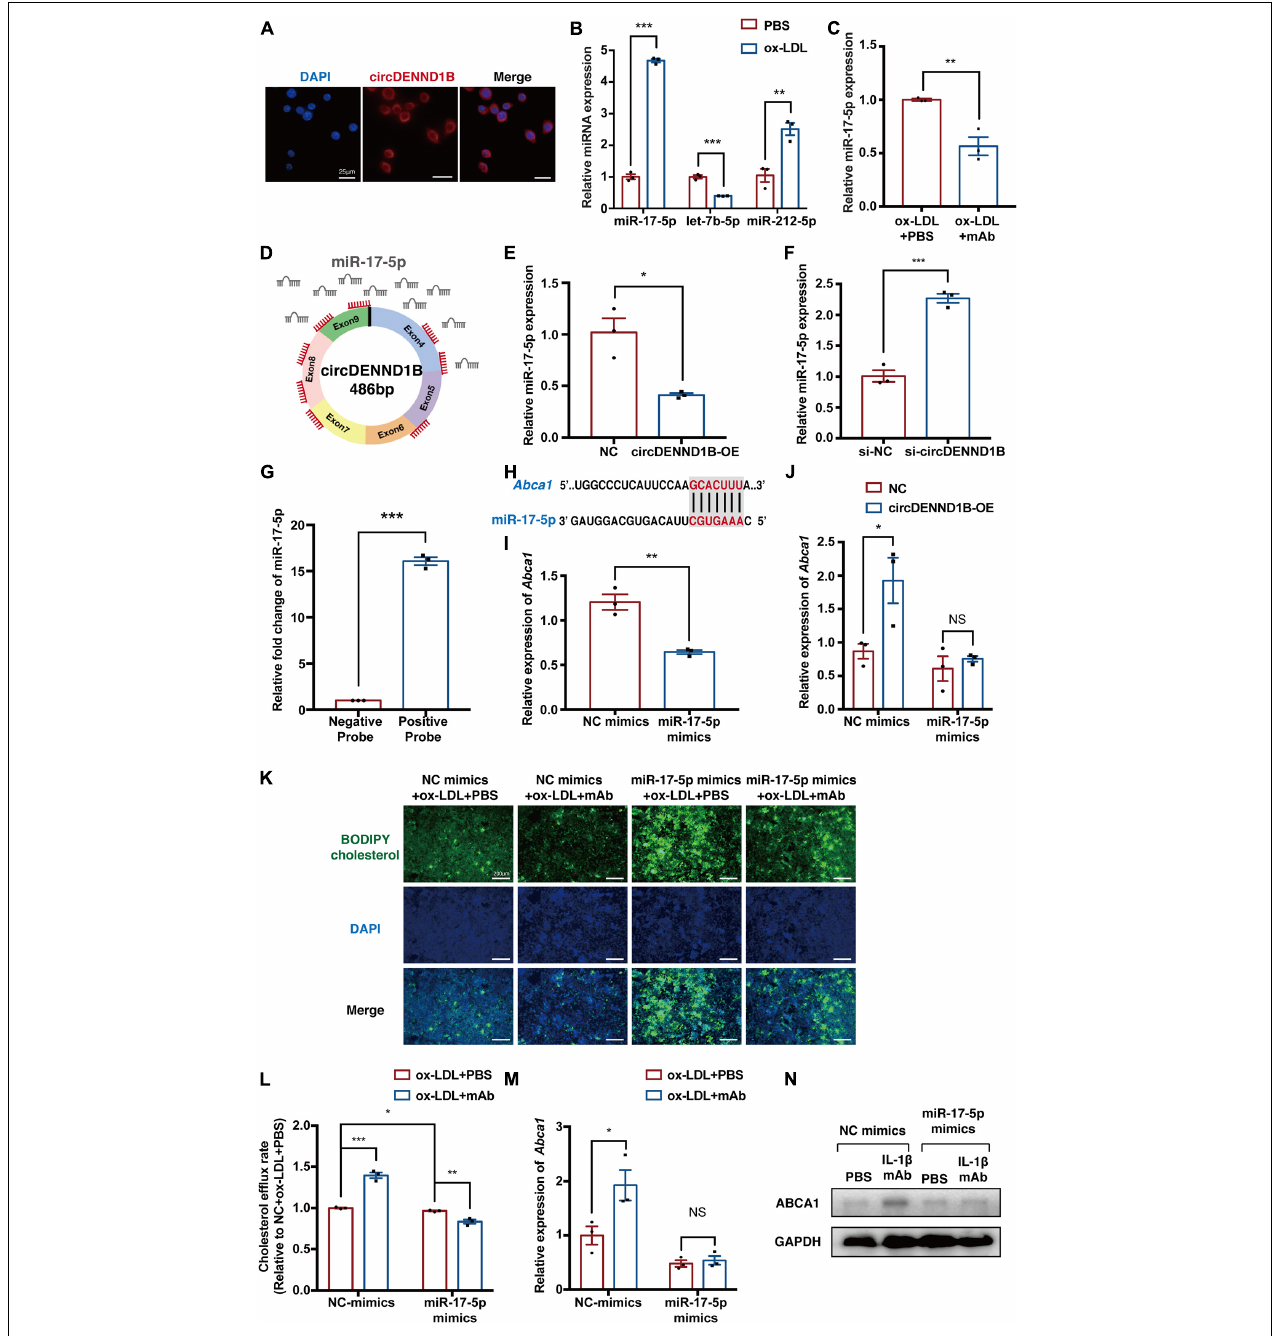
FIGURE 5 | circDENND1B/miR-17-5p/ Abca1 inhibits foam cell formation induced by IL-1 β mAb. (A) Fluorescence in situ hybridization (FISH) assay showing that circDENND1B is localized in the cytoplasm. (B) qRT-PCR results of let-7b-5p, miR-17-5p and miR-212-5p in ox-LDL-treated cells. (C) qRT-PCR results of miR-17-5p in cells treated with ox-LDL and PBS or IL-1 β mAb. (D) Schematic of the miR-17-5p sponge mechanism of circDENND1B, showing eight binding sites (red) of miR-17-5p (gray) in circDENND1B. (E) qRT-PCR shows miR-17-5p expression decreased after overexpressing circDENND1B. (F) qRT-PCR shows miR-17-5p expression increased after knocking down circDENND1B. (G) RNA pull-down assay confirmed the binding between circDENND1B and miR-17-5p. (H) miR-17-5p was predicted to bind the 3 (cid:48) UTR of Abca1 . (I) qRT-PCR results of Abca1 in foam cells treated with NC mimics or miR-17-5p mimics. (J) qRT-PCR results of Abca1 in cells transfected with miRNA mimics and overexpressing circDENND1B. (K) Representative images of the BODIPY assay showing the impact of miR-17-5p mimics and IL-1 β mAb on cholesterol efflux. (L) Cholesterol efflux rate in miR-17-5p-mimics-treated cells, measured by BODIPY assay. (M) qRT-PCR results of Abca1 in cells transfected with miRNA mimics ( n = 3 per group). (N) WB results of ABCA1 in cells transfected with miR-17-5p and treated with ox-LDL plus PBS or IL-1 β mAb. The qRT-PCR data of mRNA were normalized to GAPDH data ( n = 3 per group), and miRNA expression levels were normalized to U6 levels ( n = 3 per group). NC, negative control; OE, overexpression; NC mimics, negative control miRNA mimics. * p < 0.05, ** p < 0.01, *** p < 0.001.